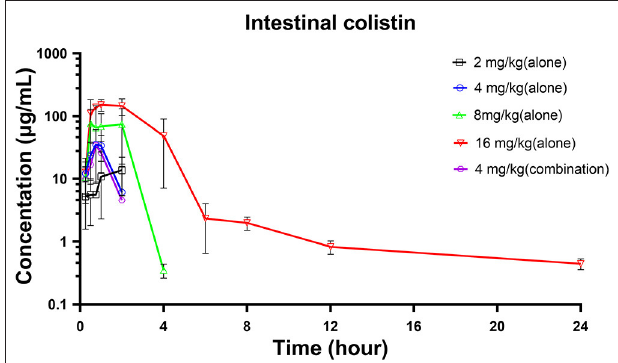
FIGURE 2 | Intestinal colistin concentration-time courses in broilers infected with mcr-1 -positive Salmonella following single gavage of 2, 4, 6, 8, and 16